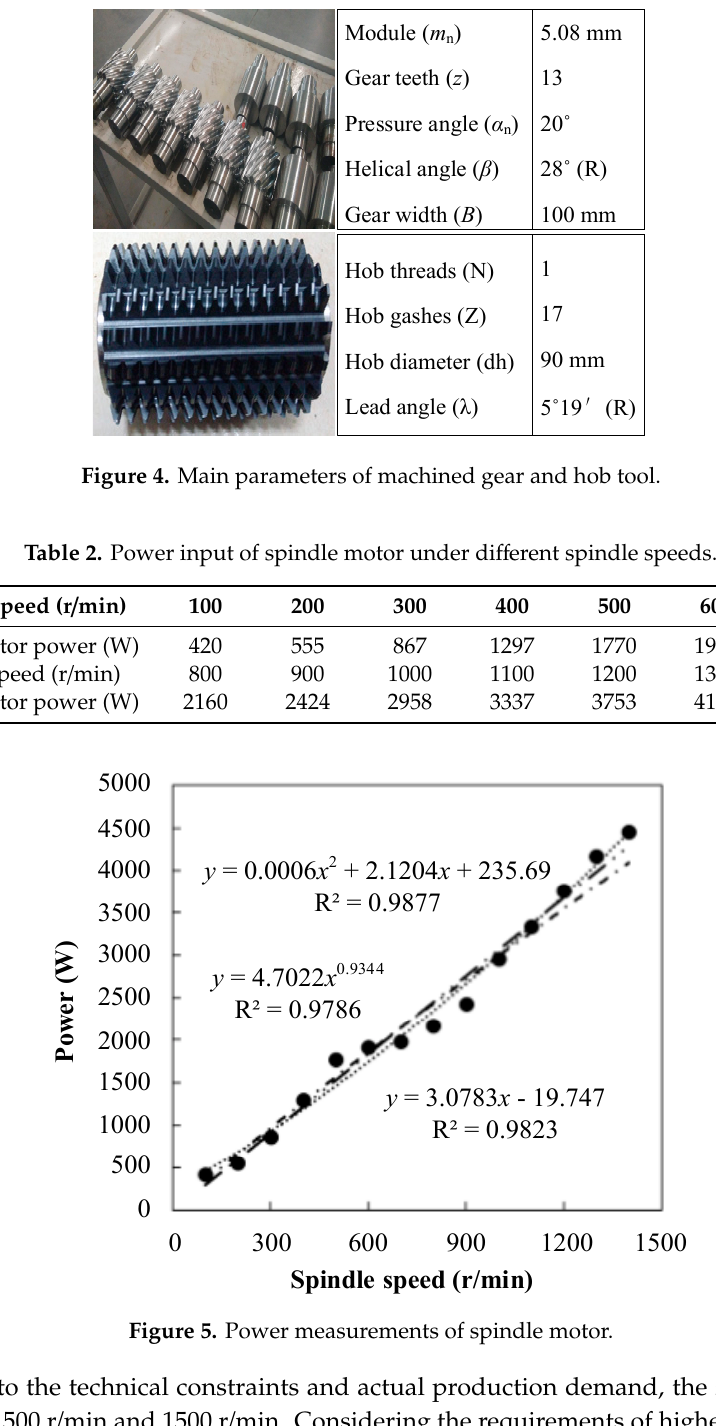
Figure 3. Experimental test for validation: ( a ) Gear hobbing; ( b ) Motorized spindle; ( c ) Refrigerated